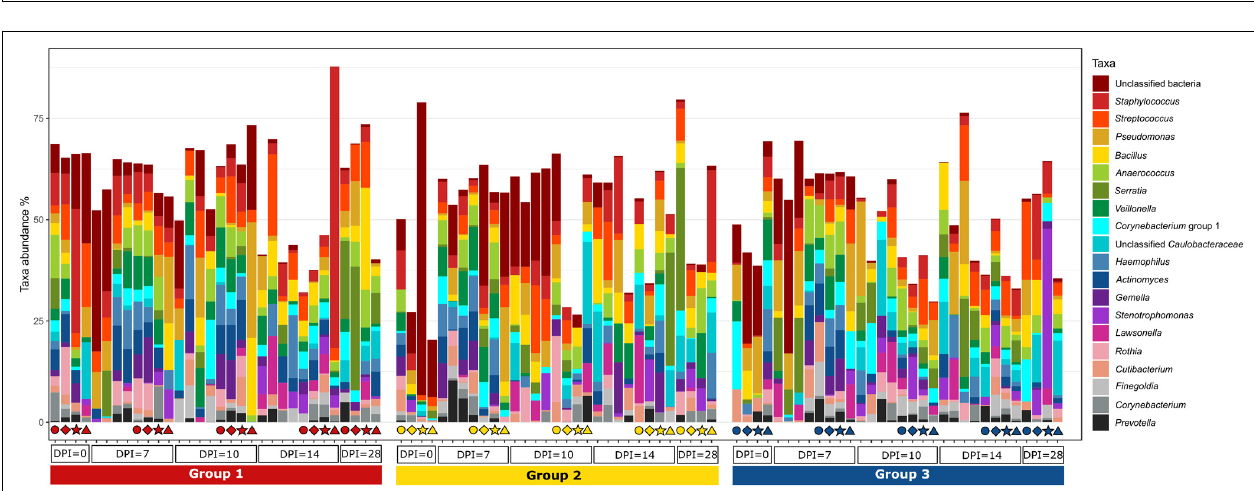
FIGURE 7 | Alpha diversity analyses in blood samples. Each dot corresponds to one bird. Group 1, infected with H. meleagridis + lux -tagged E. coli ; Group 2, infected with lux -tagged E. coli ; Group 3, negative control. dpi denotes for days post H. meleagridis infection.